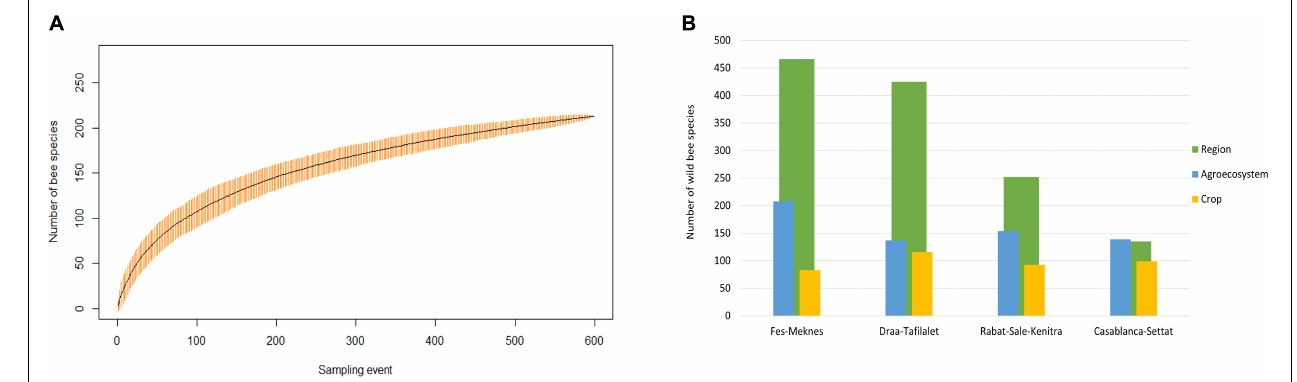
FIGURE 2 | (A) Accumulated number of bee species visiting crops in Morocco. Curve was plotted based on data grouped across all sites and all sampling events. (B) Number of bee species known in each of the four studied region (Lhomme et al., 2020, green bars) compared to the number of bee species collected by different methods in all agroecosystems in each regions during 2018 and 2019 (blue bars) and the number of bee species visiting crops (22 crops; yellow bars).